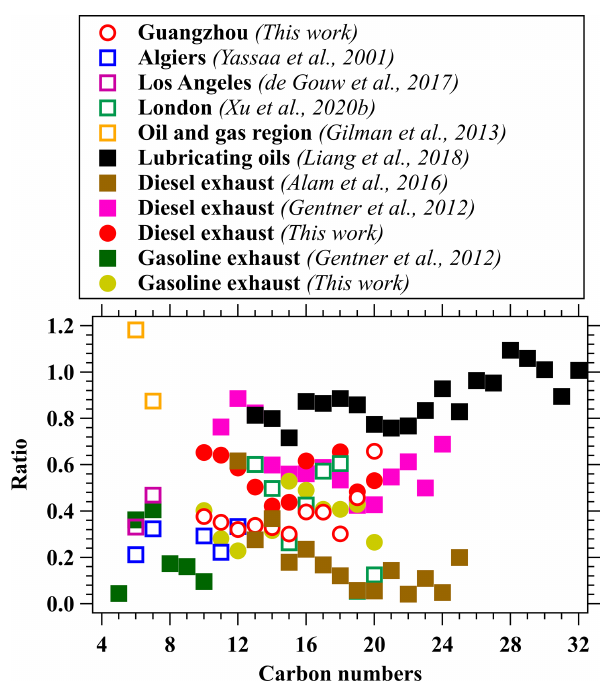
Figure 9. The concentration ratios of cyclic alkanes to acyclic alka- nes for different carbon numbers. Measurements in various urban areas, including Guangzhou in China, London in the UK (Xu et al., 2020b), Los Angeles in the USA (de Gouw et al., 2017), Algiers in Algeria (Yassaa et al., 2001), and an oil and gas region in Colorado in the USA (Gilman et al., 2013), are also shown for comparison. Emission sources, including vehicle exhausts (Alam et al., 2016; Gentner et al., 2012) and lubricating oils (Liang et al., 2018), are also